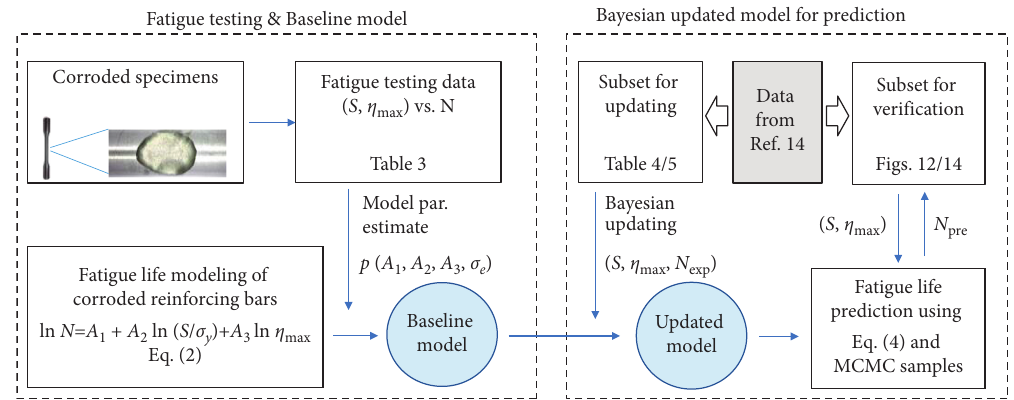
Figure 1: Overall method development process.